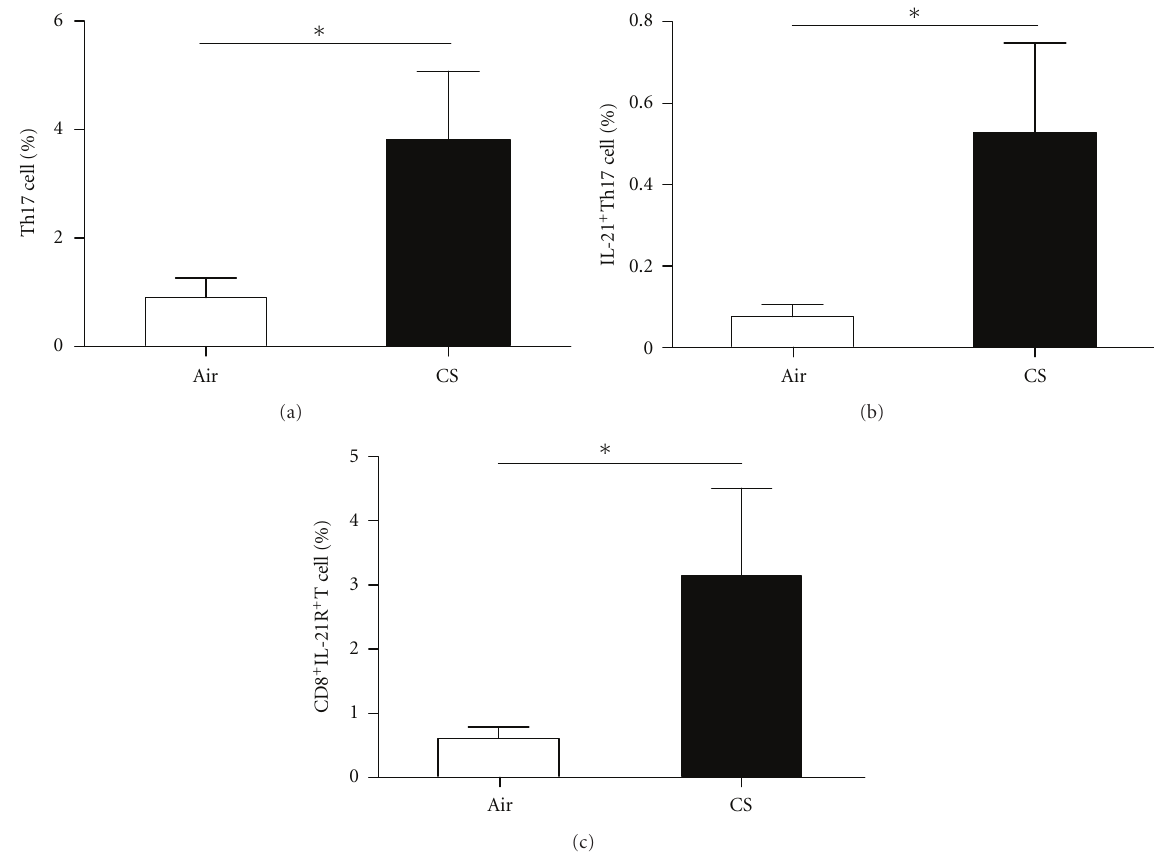
Figure 4: The frequency of CD4 + IL-17 + (Th17), cells, IL-21 + Th17 cells and CD8 + IL-21R + T cells in peripheral blood was measured by using flow cytometry. The frequency (%) of CD4 + IL-17 + (Th17) cells (a), IL-21 + Th17 cells (b), and CD8 + IL-21R + T cells (c) increased in peripheral blood of CS-exposed mice compared with air-exposed mice. Results are expressed as % (mean ± SD). n = 10 animals/group; ∗ P < 0 . 05.